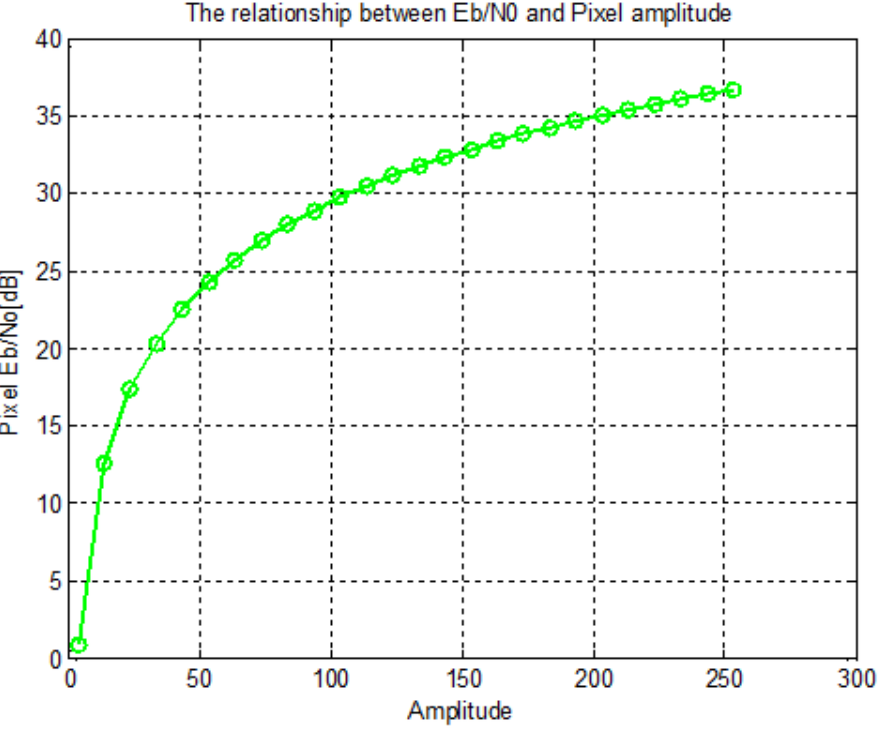
/ E N ratio and image ampli- 0 b